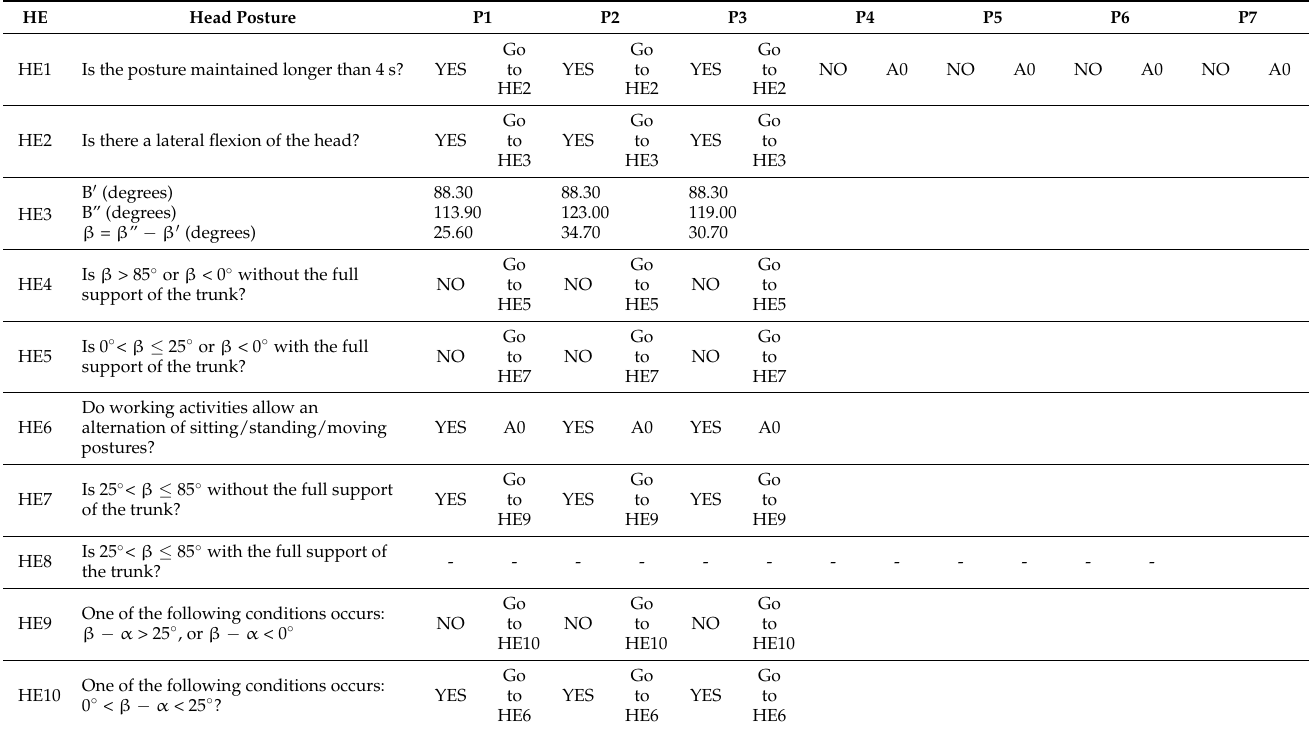
Table A2. Head posture